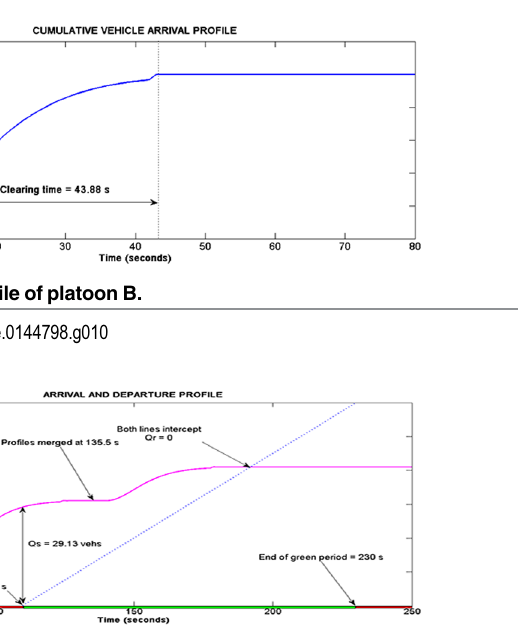
Fig 11. Arrival and departure profile at Intersection